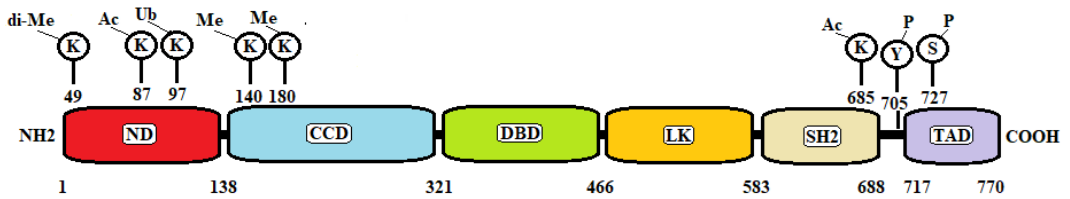
Figure 1. Structure of signal transducer and activator of transcription 3 (STAT3). Functional domains: ND, NH2-terminal domain; CCD, coiled-coil domain; DBD, DNA-binding domain; LK, linker domain; SH2, Src homology 2 domain; TAD, transactivation domain. STAT3 activation is dependent on the phosphorylation (P) of a tyrosine residue Y705, which is located between the SH2 domain and TAD. Phosphorylation on serine (S) 727 is required for maximal transcriptional activity. After cytokine treatment, STAT3 is acetylated (Ac) on lysine (K) K87 and 685. Other post-translational modifications are di-methylation (di-Me) of K49, monoubiquitination of K97, and methylation (Me) of K140 and K180.